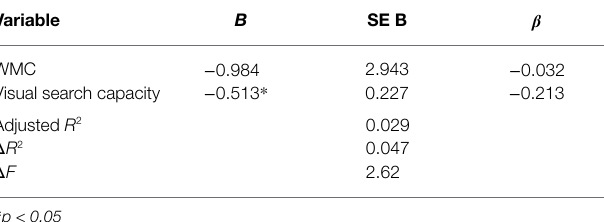
TABLE 4 | Summary of the standard multiple regression for resumption lag following 5-s interruptions. Variable